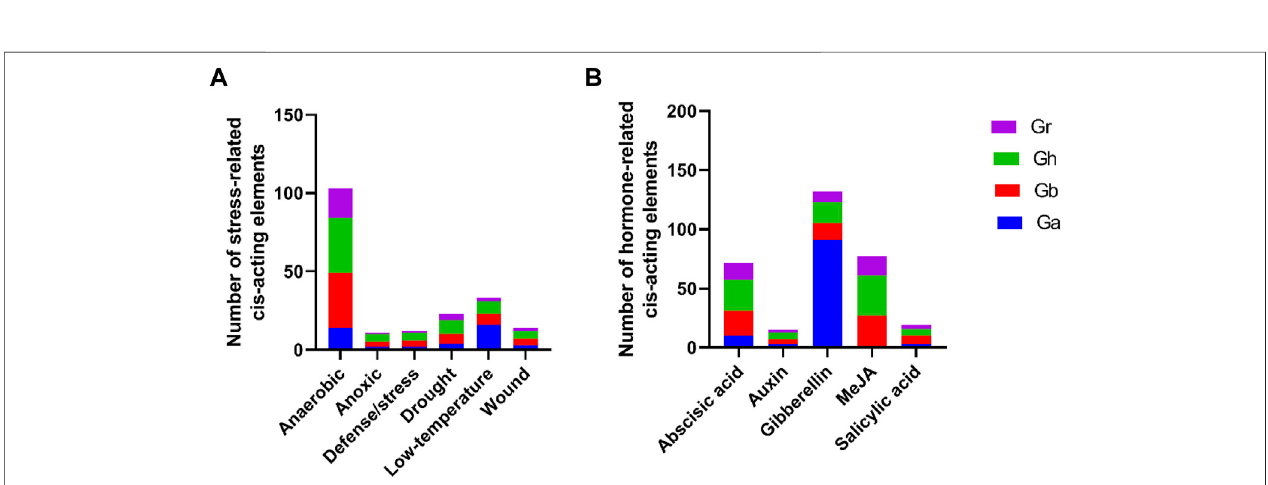
FIGURE3| Cis-elementanalysisof GIF promotersinfour Gossypium species. (A) analysisofthestress-relatedcis-actingelements (B) analysisofhormone-related cis-acting elements.